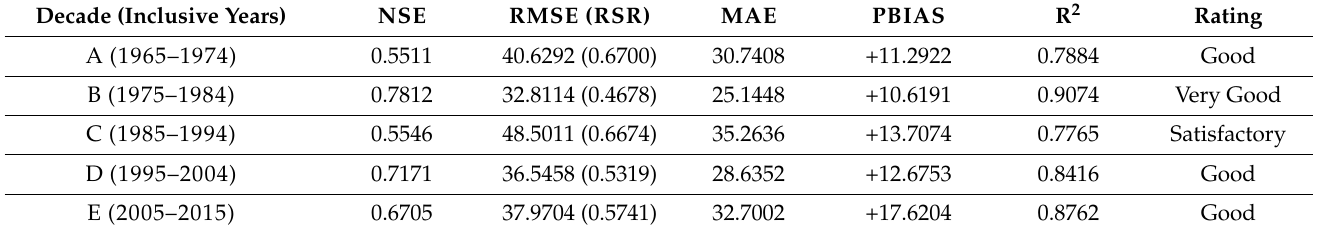
Table 2. Model performance of the initial streamflow calculation using default parameters.